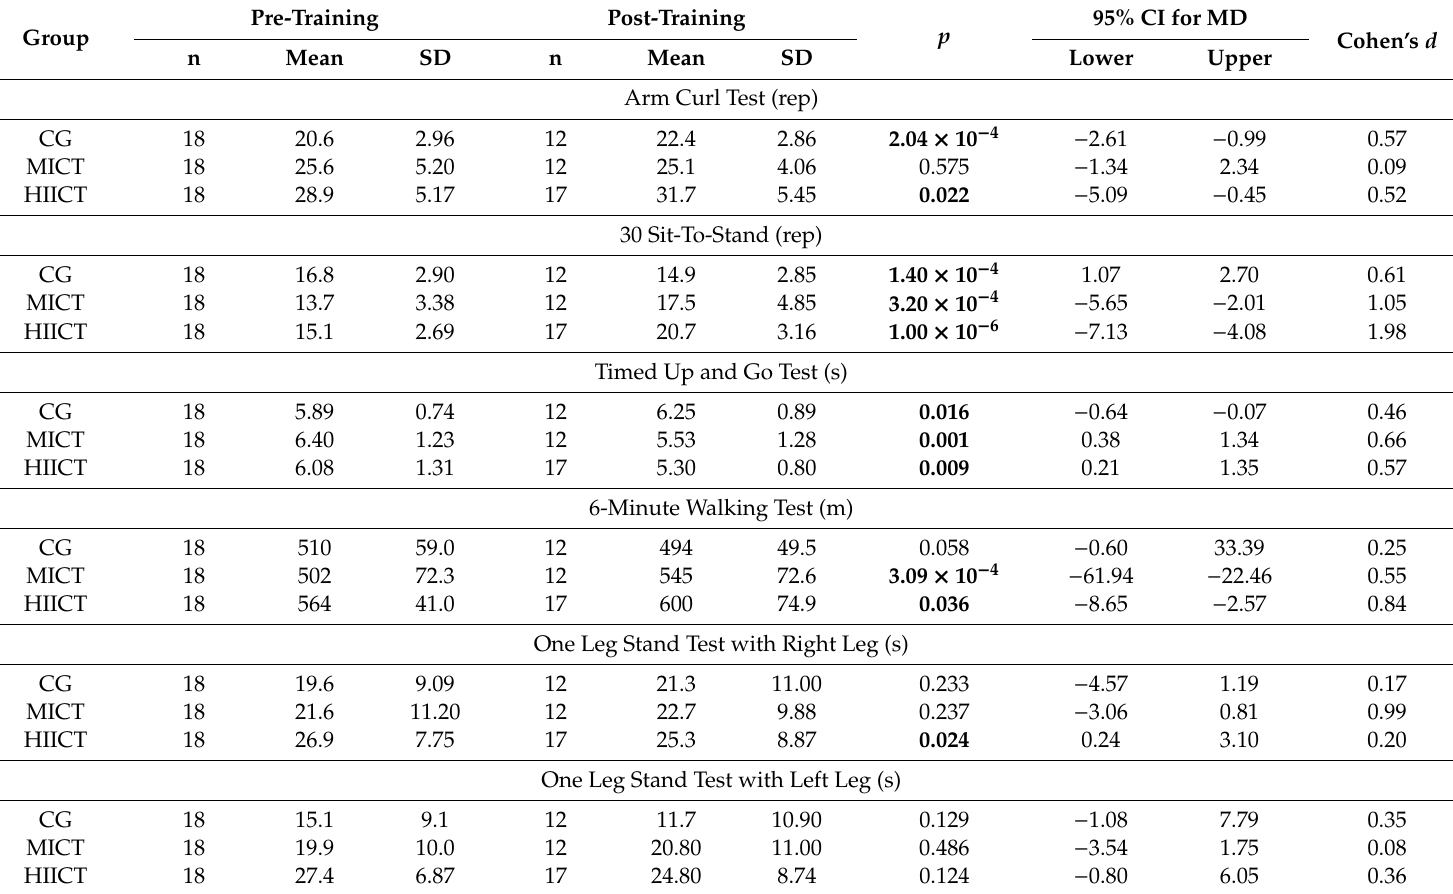
Table 6. Intra-group di ff erences for the primary outcomes on HIICT, MICT and